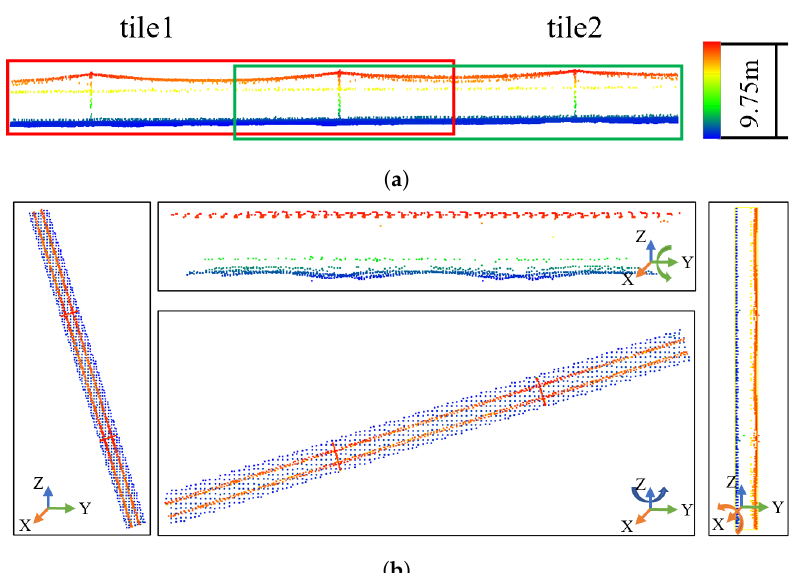
Figure 3. Data augmentation. ( a ) training data re-tiling; ( b ) rotation amplification. The four images are the visualization of the original tile and the rotated tile on the XOY